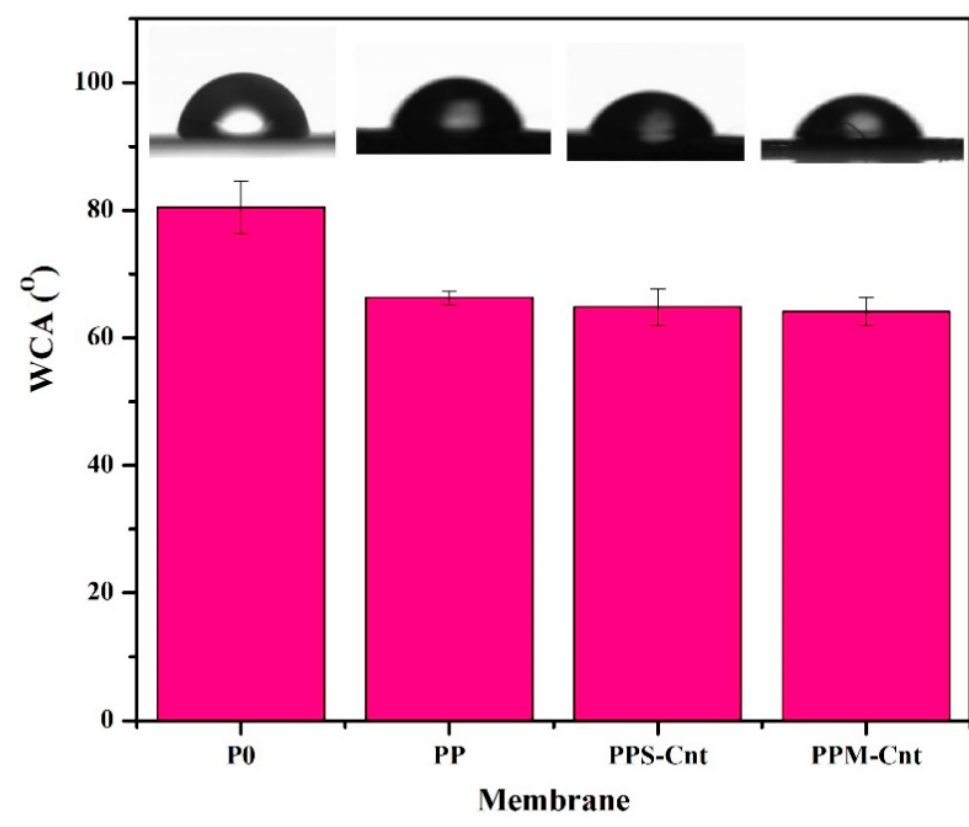
Figure 4. Membrane surface water contact angle (WCA).